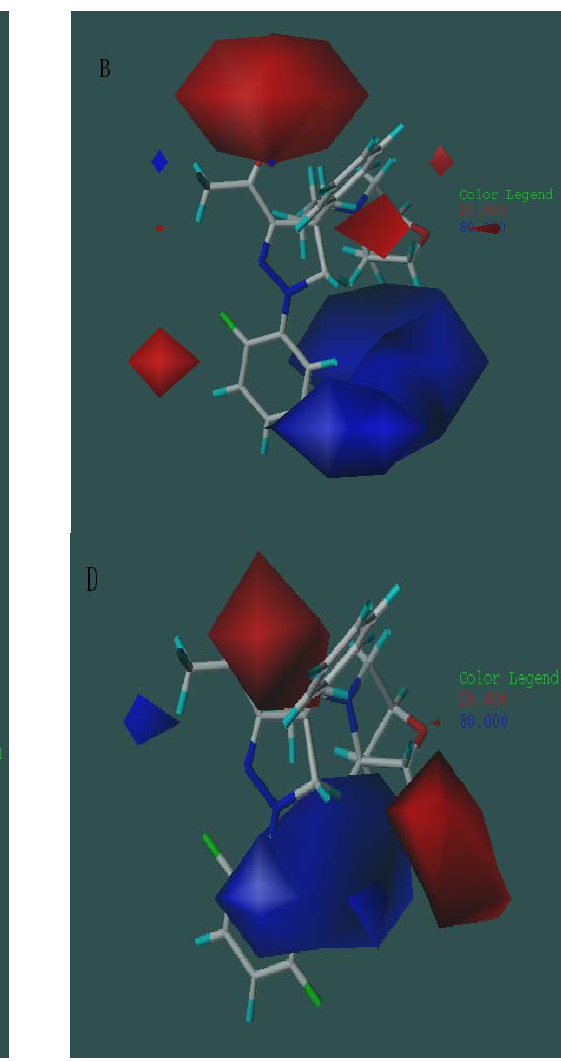
Figure 4. Molecule A was placed inside of the fields of the CoMFA and CoMSIA models 01 and all the contour cutoff levels were set at